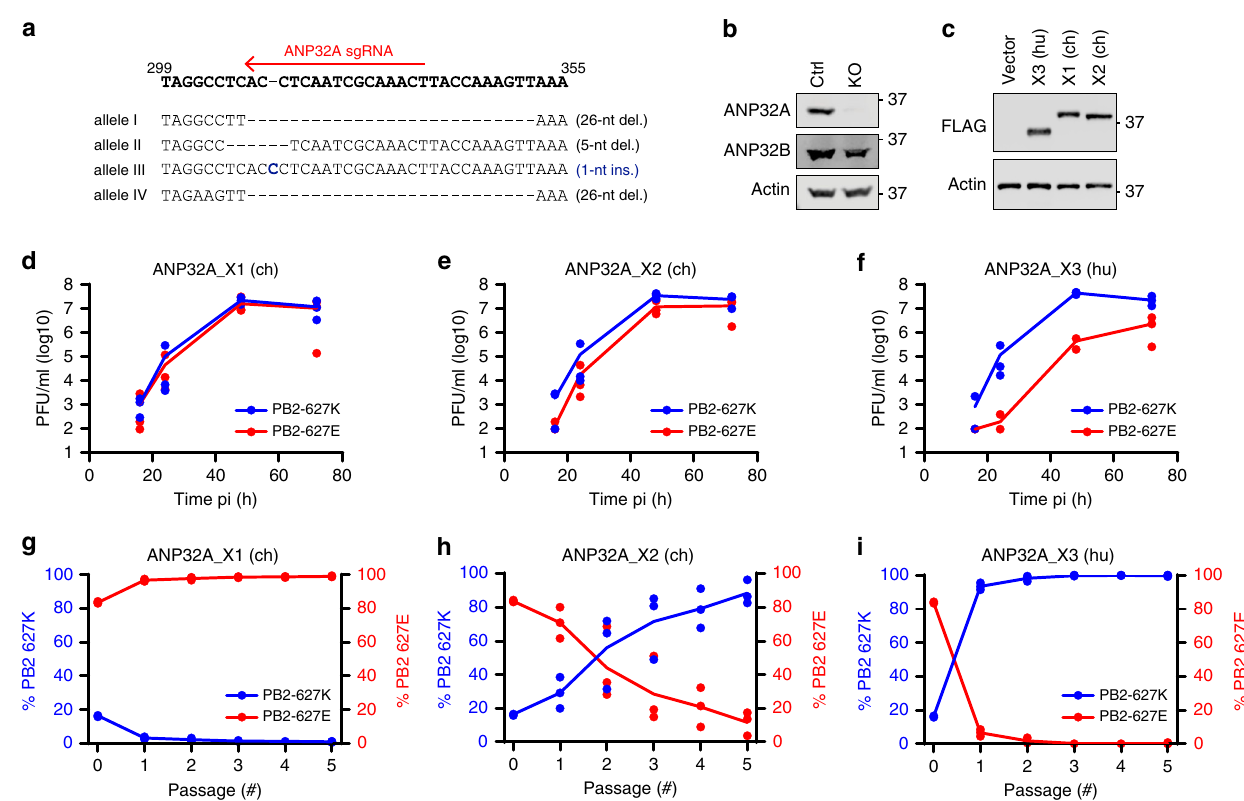
Fig. 2 ANP32A variants differentially impact avian-signature IAV replication and selection. a Genotype of the A549-ANP32A KO cell-clone used in this study. The target site of the crRNA is depicted. Four distinct ANP32A alleles were detected in A549s suggesting duplication of chromosome 15. b Western blot analysis of parental A549 (Ctrl) and A549-ANP32A KO (KO) cells for ANP32A, ANP32B, and actin. c Western blot analysis of A549-ANP32A KO cells stably reconstituted with the indicated FLAG-ANP32A constructs or empty vector. d – f Viral growth kinetics of rWSN-based viruses expressing PB2-627E or PB2-627K in the indicated ANP32A-reconstituted cell-lines (MOI = 0.001 PFU/cell). g – i Competition assays between rWSN-based viruses expressing PB2-627E or PB2-627K (5:1 input ratio) in the indicated ANP32A-reconstituted cell-lines. P0 represents input. Percentage of PB2-627K/E was determined by NGS. In panels d – i , mean values from three independent experiments are plotted with lines, and the individual data points are shown. For panels b and c , representative data from two independent experiments are shown. Source data for panels b – i are provided in the Source Data fi